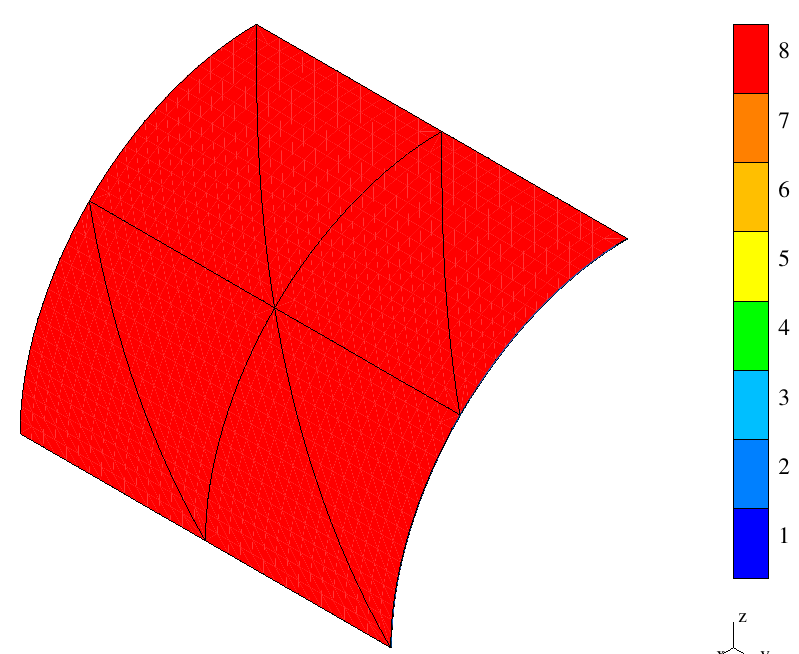
Figure 23. A quarter of a bending-dominated shell—after simple detection and h -adaptation